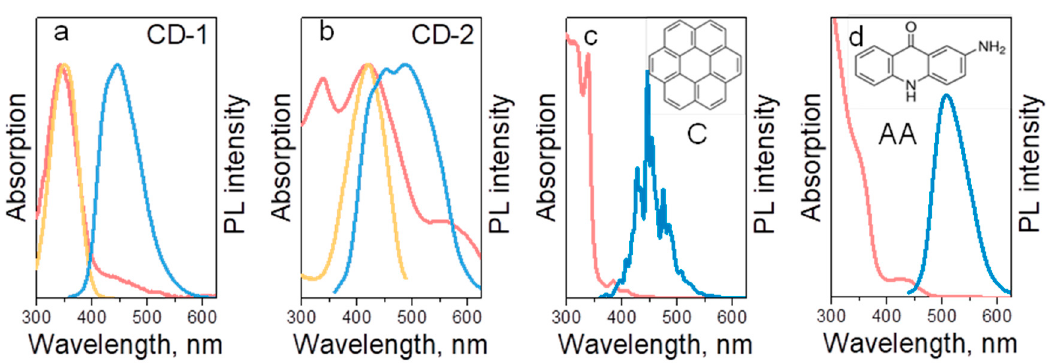
Figure 2. Optical characteristics of ( a ) CD-1 in water, ( b ) CD-2 in methanol, ( c ) coronene (C) in toluene, and ( d ) 2-aminoacridone (AA) in DMF. Absorption spectra are presented in red; PLE spectra (monitored at 450 nm in ( a ), and at 500 nm in ( b )) are presented in orange; PL spectra excited at 350 nm are provided in blue. Chemical structures of C and AA molecules are provided on the respective frames.